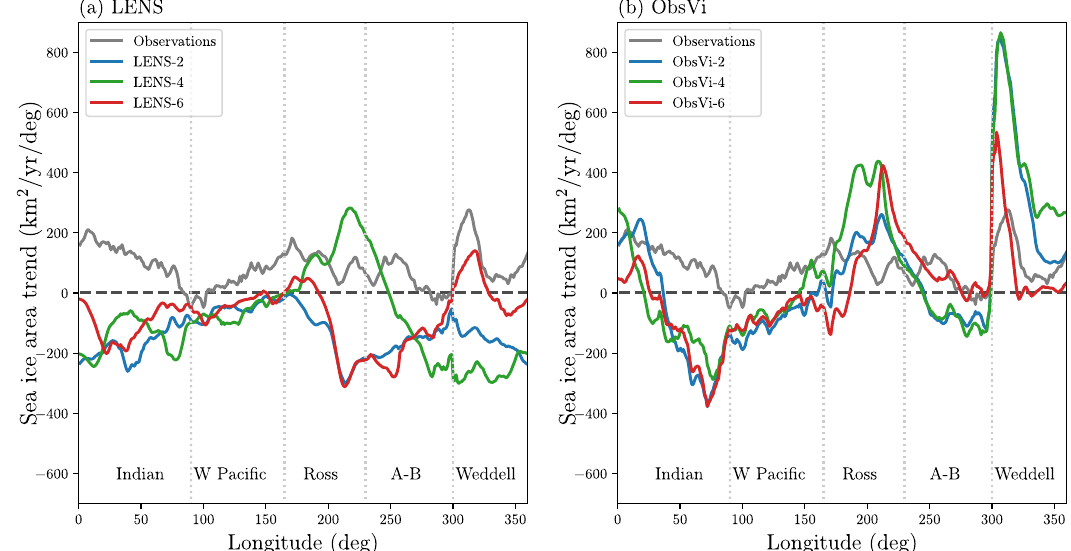
Fig. 3 Spatial structure of Antarctic sea ice trend. Linear trend in the annual-mean meridionally-integrated sea ice area during 1992 – 2015 as a function of longitude in the a LENS and b ObsVi simulations. Observations are plotted for comparison as a gray line in both panels. The longitude ranges of the different Southern Ocean sectors are labeled and separated with gray dotted lines. Here, “ A-B ” stands for the Amundsen-Bellingshausen Sea and “ W Paci fi c ” refers to the western Paci fi c